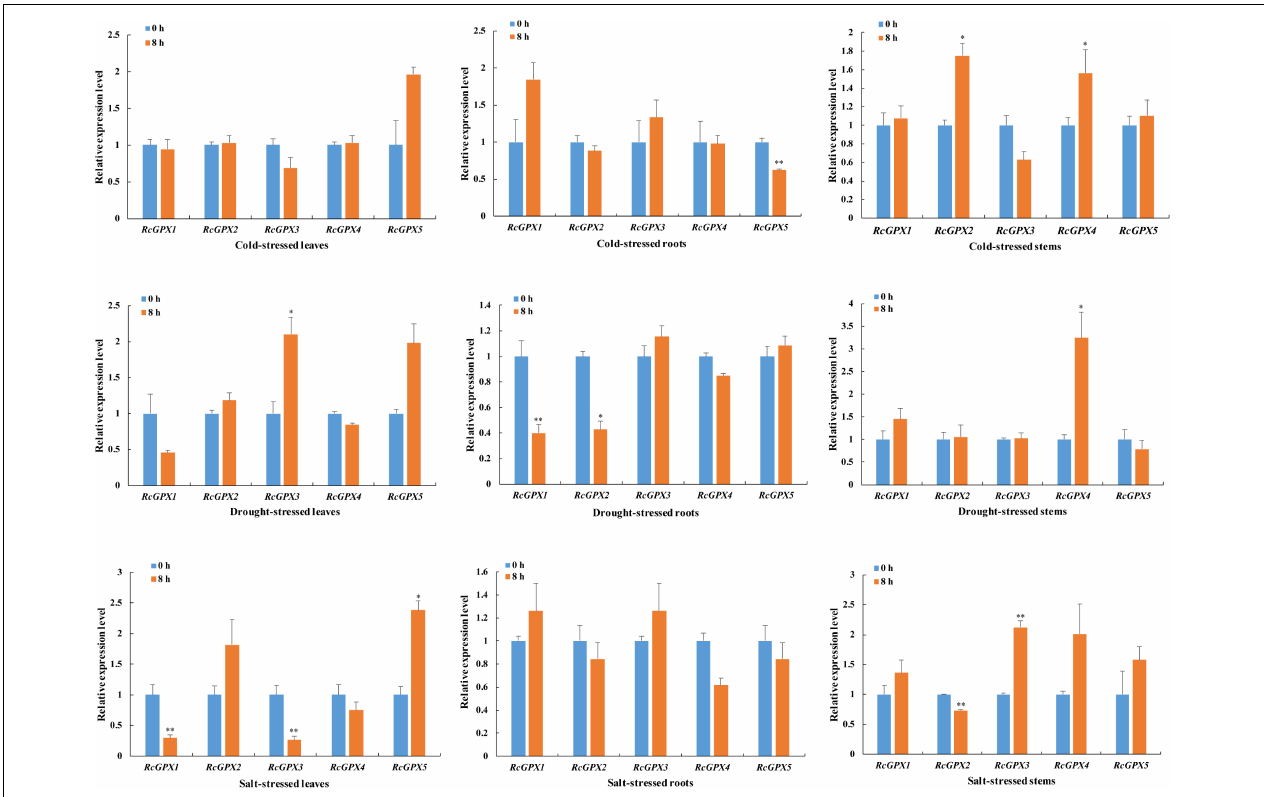
FIGURE 4 | Effect of different stresses on the expression of the RcGPX s in leaves, roots, and stems. Total RNA was extracted from the leaves, stems, and roots of 3-week-old castor seedlings subjected to salt (300 mM), cold (4 ◦ C), and drought (15% PEG) treatments at 0 and 8 h. 0 h treated plants were used as controls. Data represent the means ± SD of three independent biological replicates. ∗ P < 0.05, ∗∗ P < 0.01 by Student’s t -test.